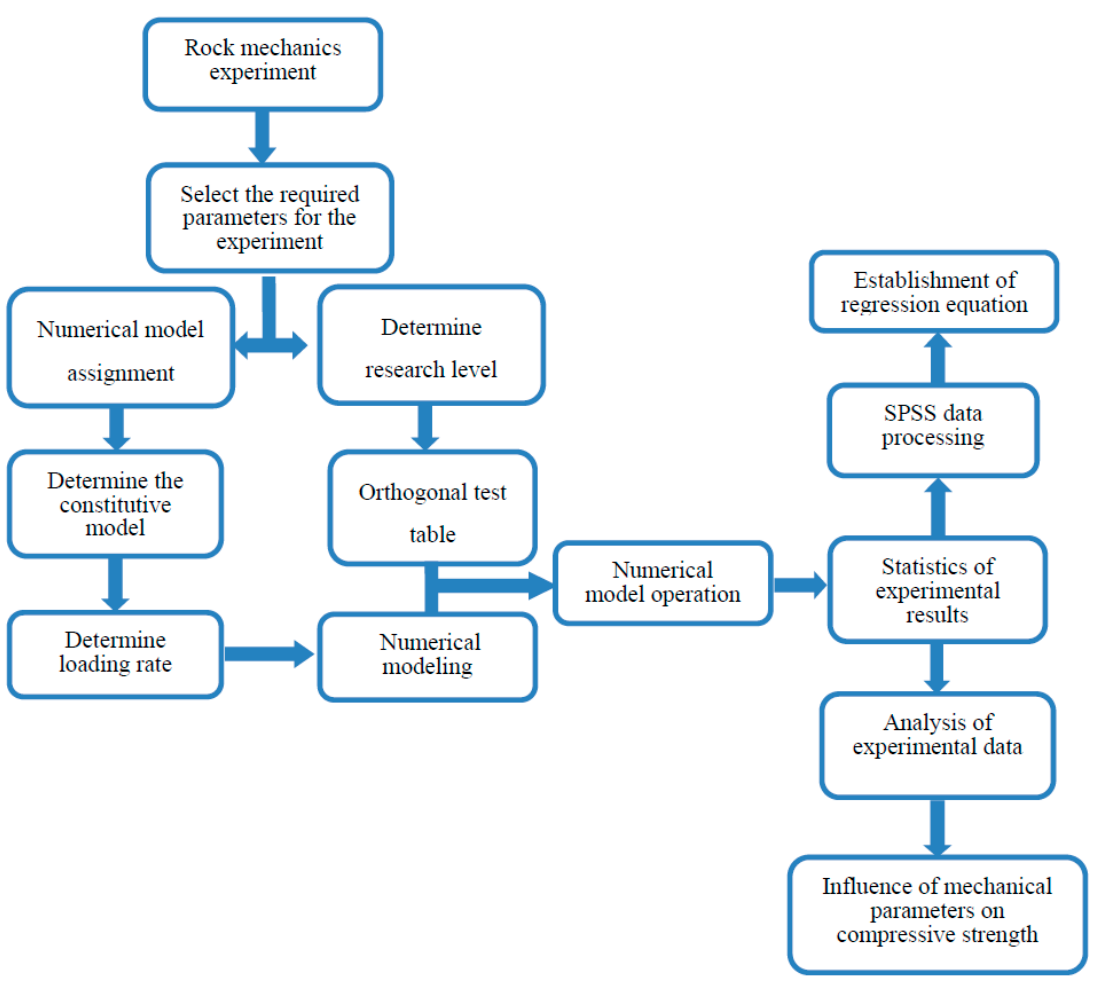
Figure 1. Technical workflow.